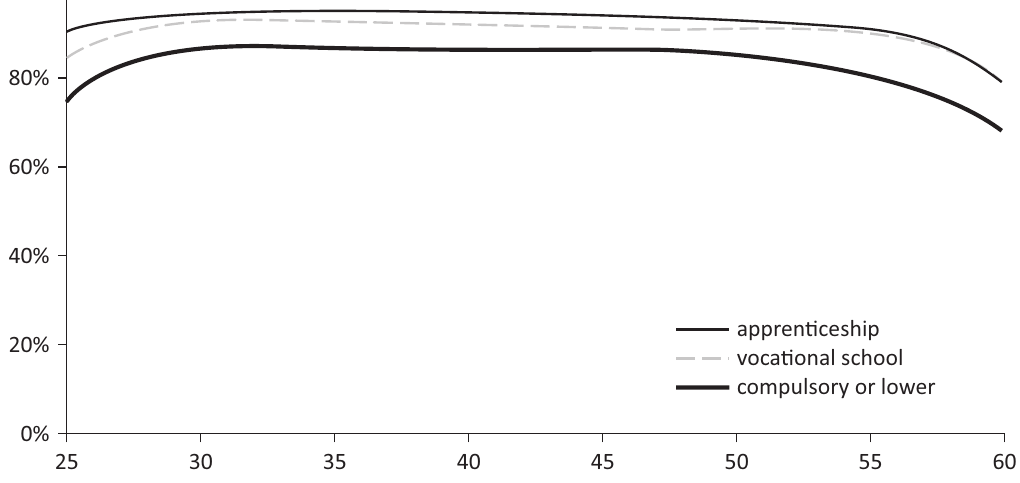
Figure A4. Employment rate (minimun 8 hours per week) by type of upper-secondary vocational education. Men— Switzerland. Source: Swiss Labour Force Survey 1991–2014.